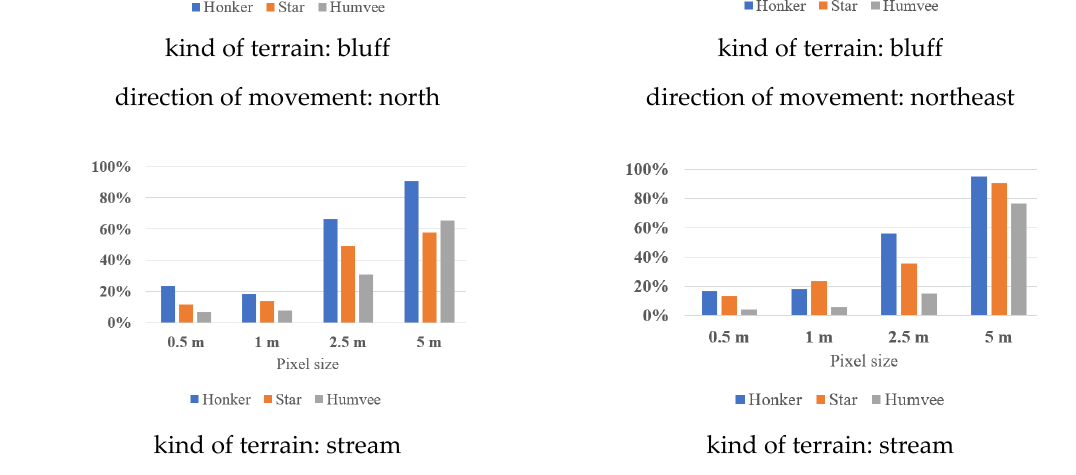
Figure 14. Percent of impassable areas indicated by the script.